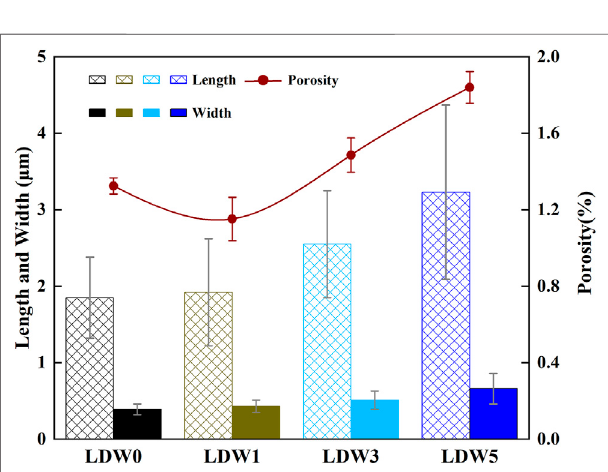
FIGURE 4 | Grain size and porosity of the Li 2 Si 2 O 5 glass-ceramics with different compositions.